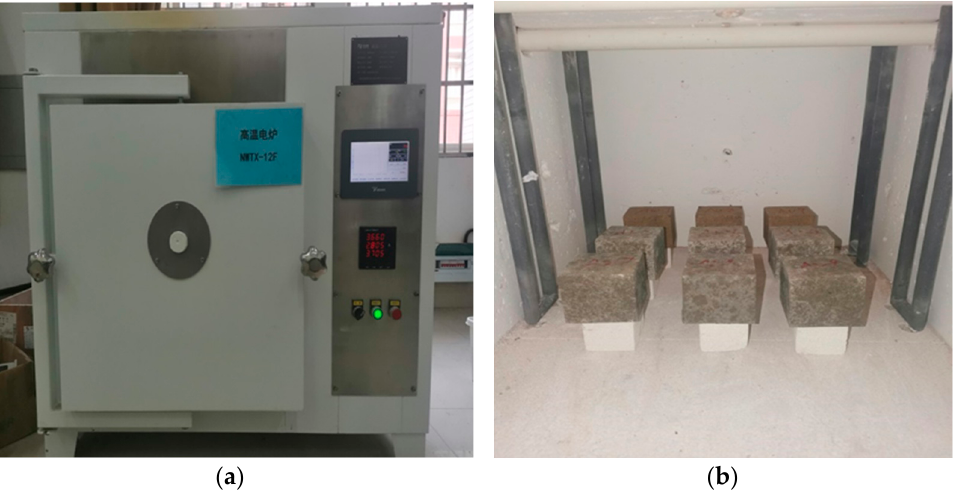
Figure 1. High ‐ temperature electric furnace and test pieces in the furnace: ( a ) High ‐ temperature electric furnace, ( b ) Test piece.